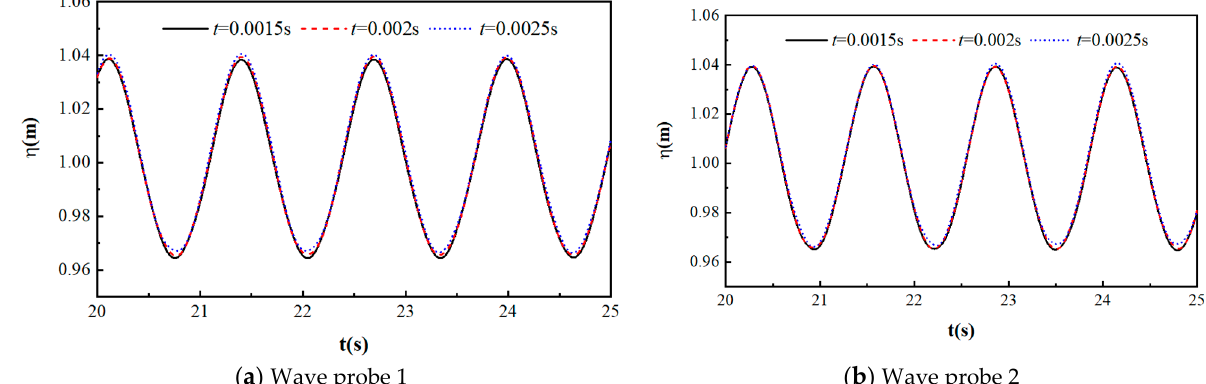
Figure 4. Comparison of the wave elevation of different time steps.